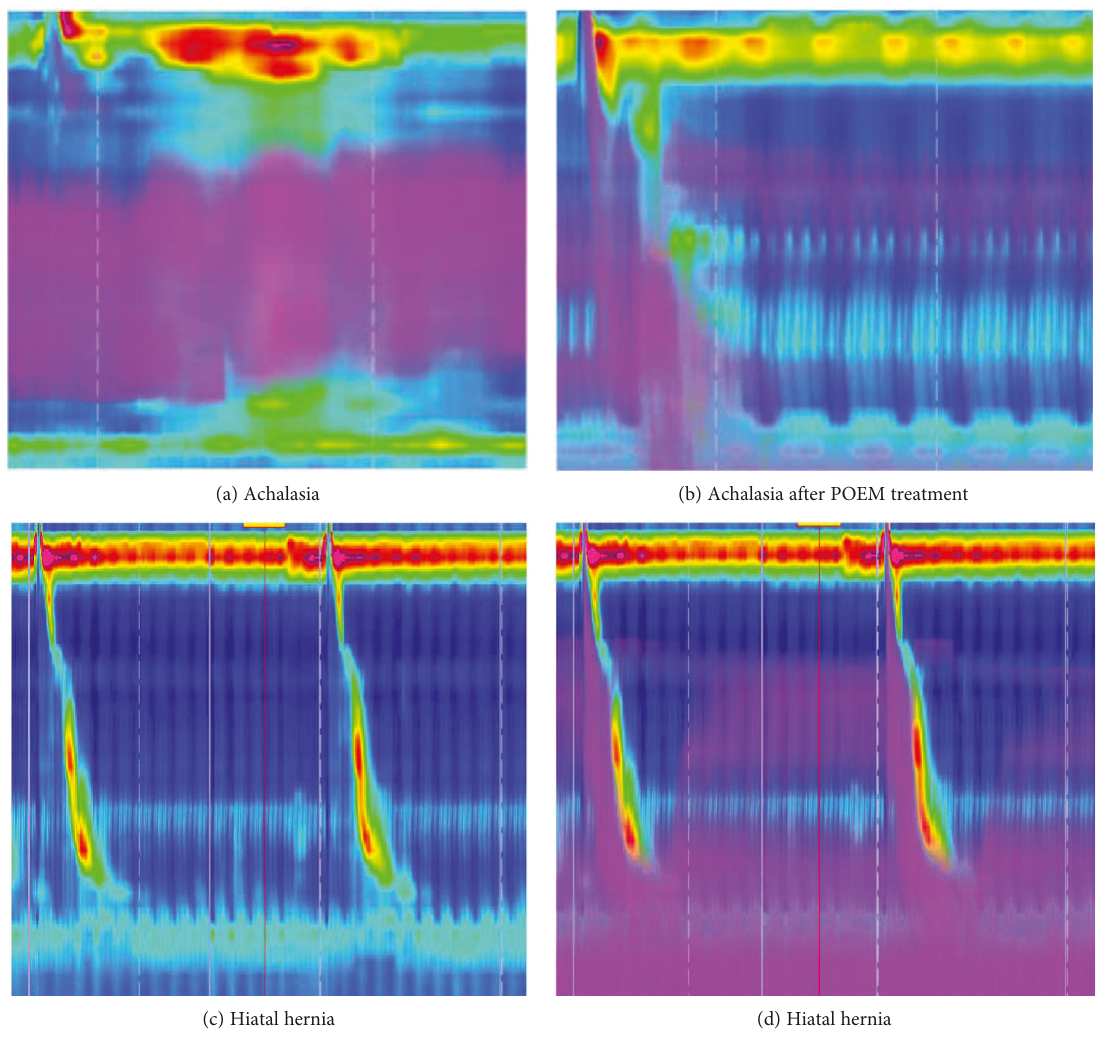
Figure 2: HRIM manifestation of one achalasia patient before and after peroral endoscopic myotomy (POEM) operation and one hiatal hernia patient. (a) One patient with II type achalasia in our study showed bolus retention in the esophagus body. (b) Four months after peroral endoscopic myotomy operation, the patient showed obvious reduced bolus retention and even exhibited proximal esophageal contraction. (c) One patient of hiatal hernia showed a 3 cm separation between the LES and CD during the baseline recording. (d) Gastroesophageal re fl ux occurred after the end of each peristaltic wave until the following